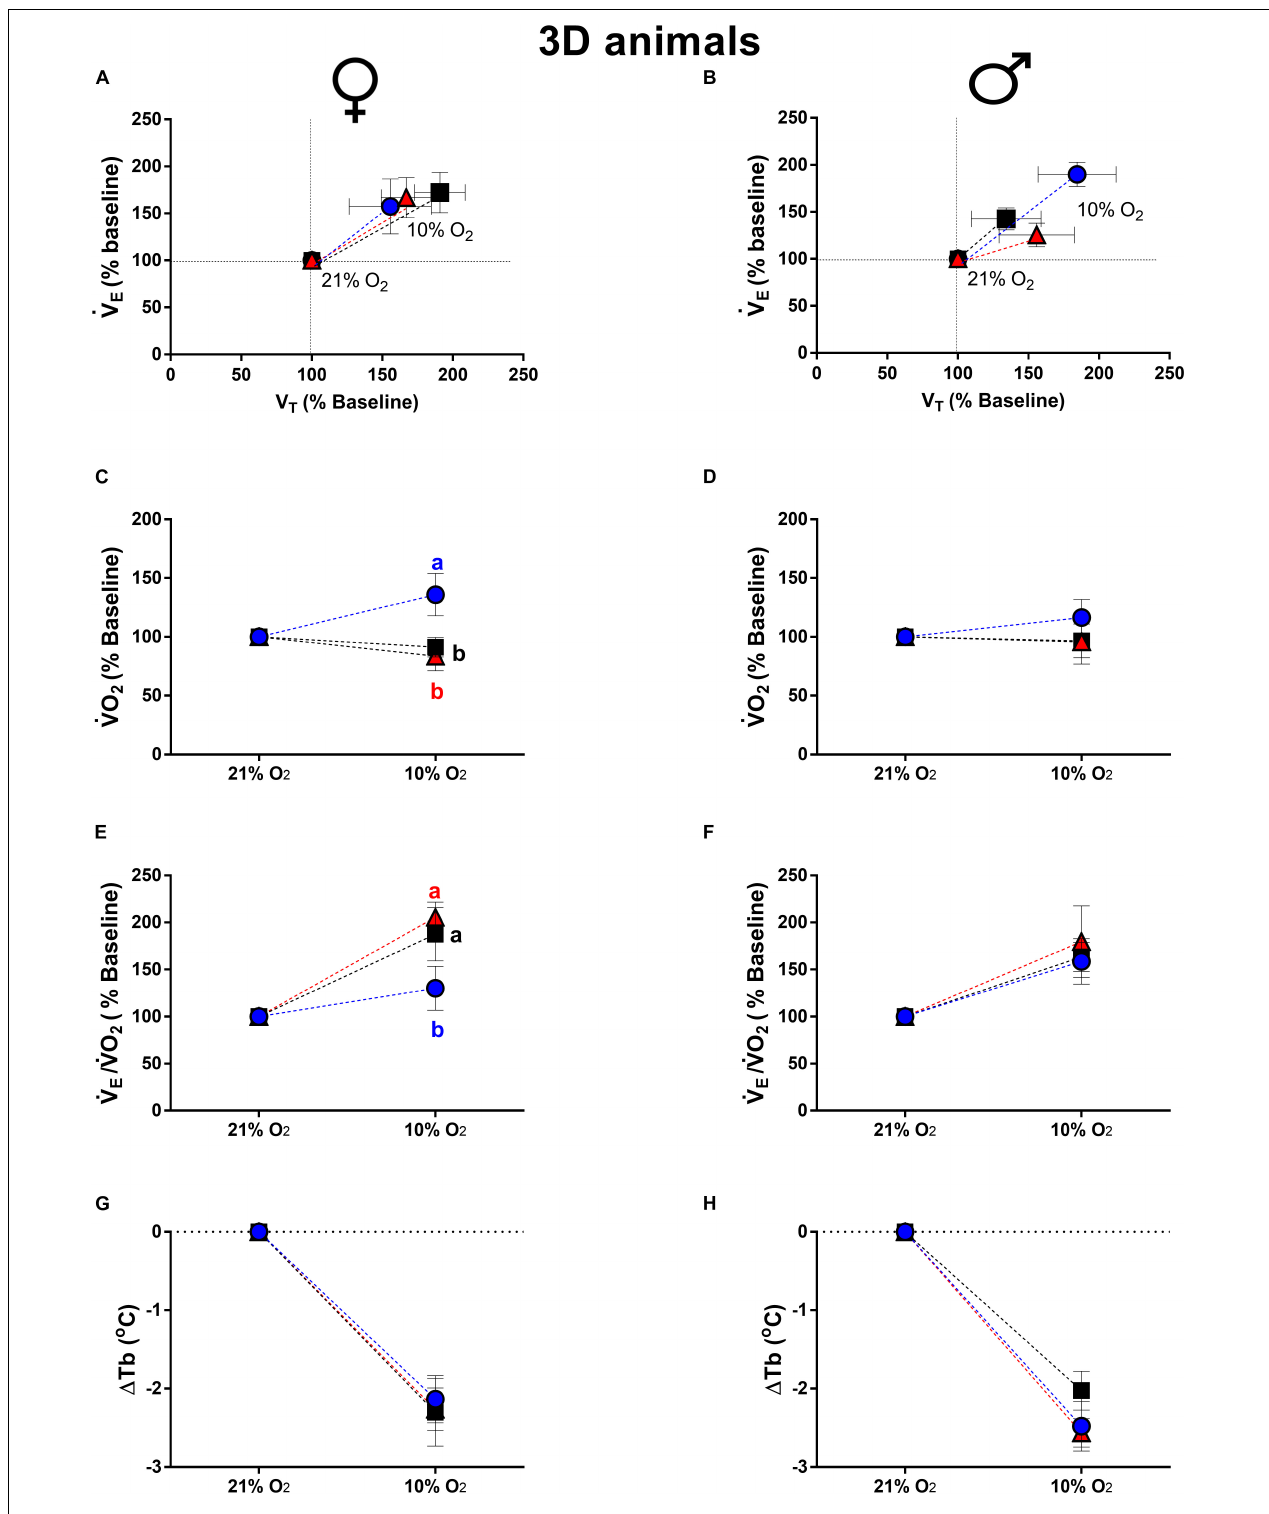
FIGURE 3 | Breathing pattern (A,B) , oxygen consumption ( ˙ V O 2 ) (C,D) , air convection requirement ( ˙ V E / ˙ V O 2 ) (E,F) and body temperature (Tb) (G,H) , during normoxia and hypoxia of 3-days-old female and male broiler chicks submitted to the experimental treatments during incubation, i.e., control temperature (CT, 37.5 ◦ C), low temperature (LT, 36 ◦ C, 6 h/day, from 0 to 5th day) and high temperature (HT, 39 ◦ C, 6 h/day, from 0 to 5th day). Values are expressed as mean ± SEM. Different letters represent statistical differences among the treatments. Level of significance: P ≤ 0.05.